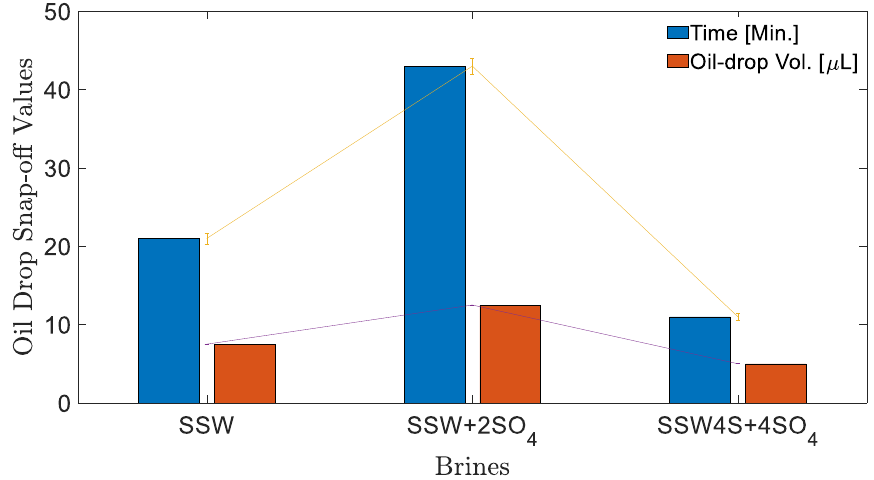
Figure 5. Oil drop-size analysis before snap-off for different brines at 22 °C. Time (Min.) shows time in minutes at which oil-drop snap-off happened and Oil-drop Vol. (µL) represents the oil-drop volume at snap-off point. Both connecting lines show the error bar range for measurements